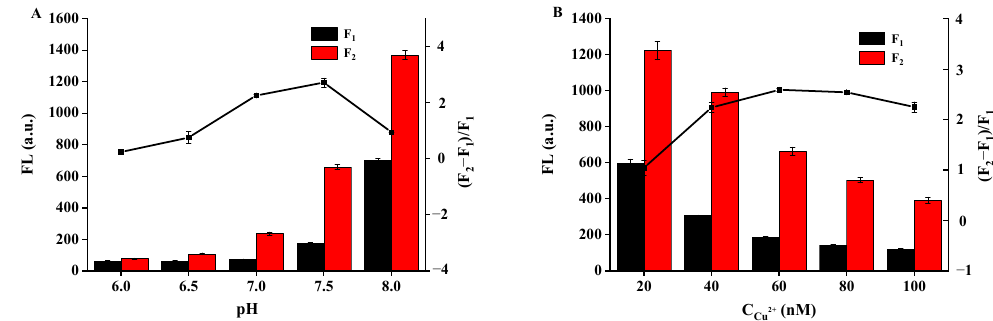
Figure 10. Effects of ( A ) pH and ( B ) different concentrations of Cu 2+ on the recovery efficiency of DNA2-Ag NCs/Cu 2+ /glyphosate.